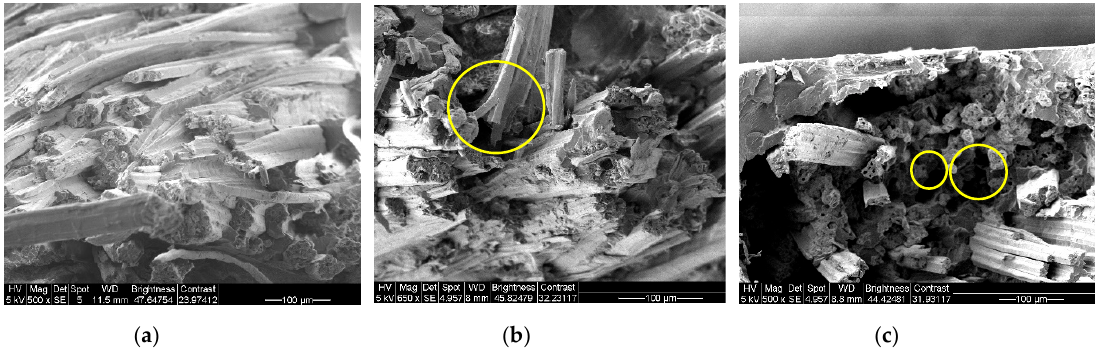
Figure 10. SEM micrographs of fracture surface of ( a ) the Control, ( b ) GnP composite and ( c ) FR composite after the tensile test at 500× magnification.